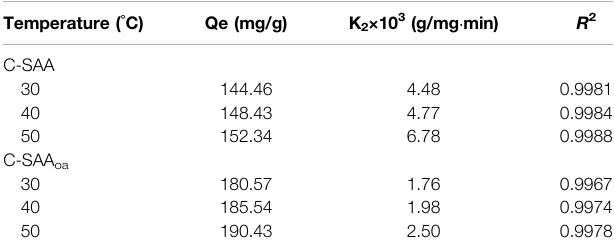
TABLE 3 | Kinetic parameters for the pseudo-second-order models at different temperatures about C-SAA and